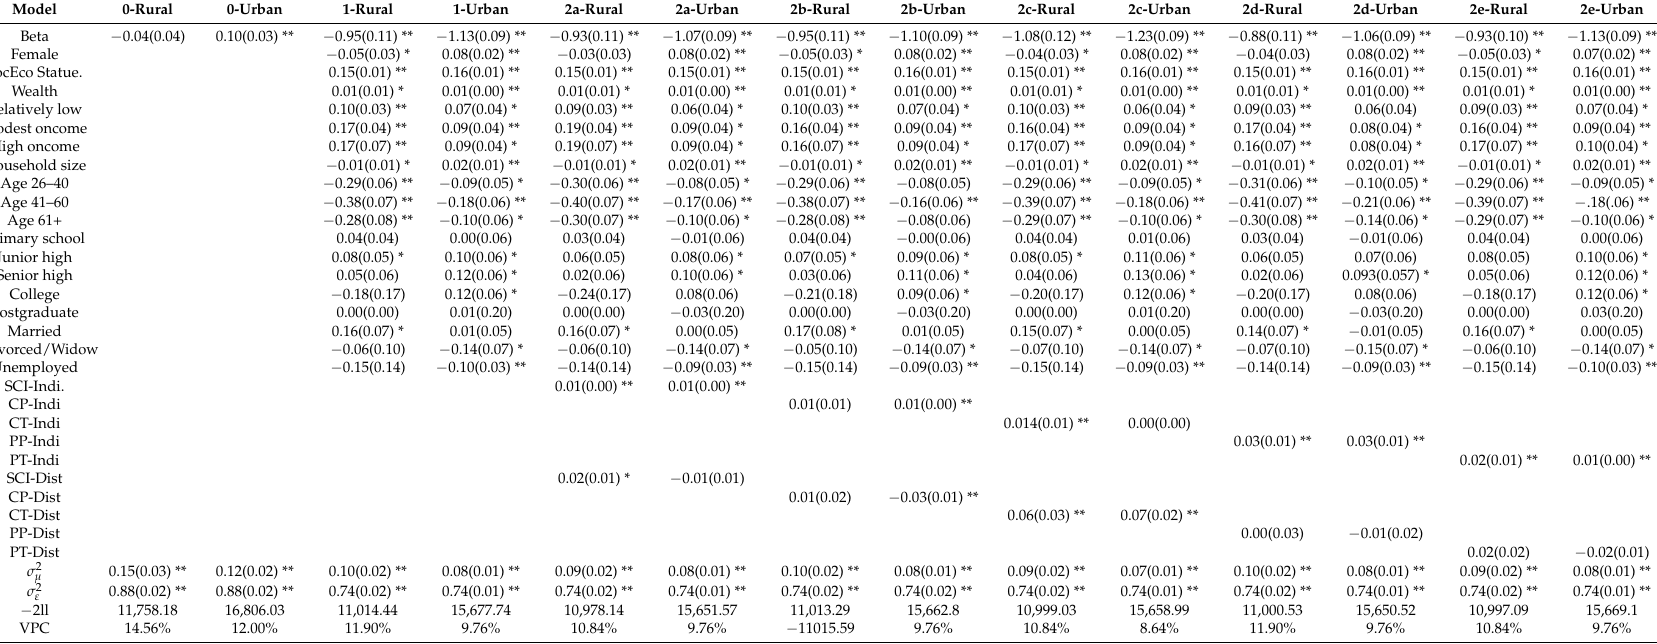
Table 2. Results of regression